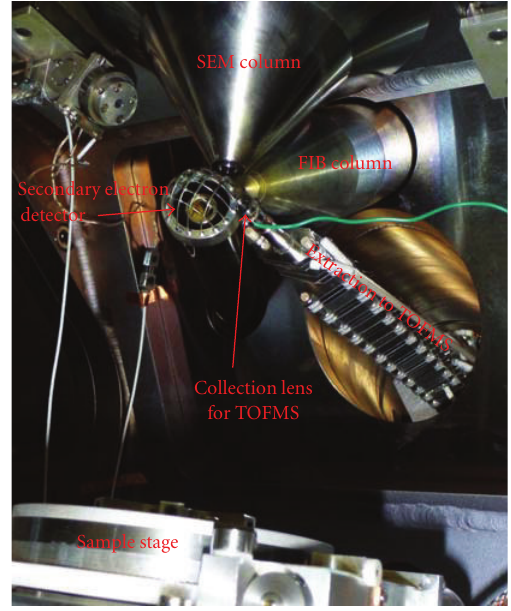
Figure 2: Interior of FIB/SEM-SIMS prototype. The sample stage has been lowered to make the arrangement of the collection lens and charged particle columns clearer. For SIMS work, the sample is usually positioned at a working distance of 9mm below the SEM column, and tilted to 55 ◦ to present the sample surface normal to the incident gallium ions. Additional instrumentation such as nanomanipulators, gas injection systems, and EDX or BSE detectors can be added as required. For SPM measurements, the SPM assembly was mounted on the sample